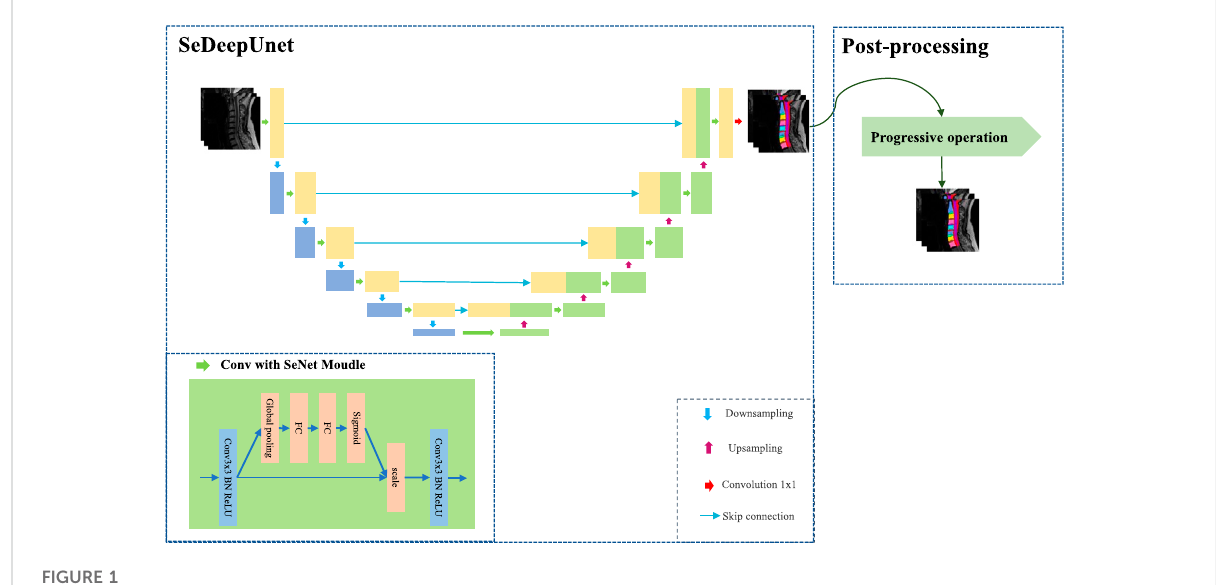
FIGURE 1 Diagram of the SeUneter